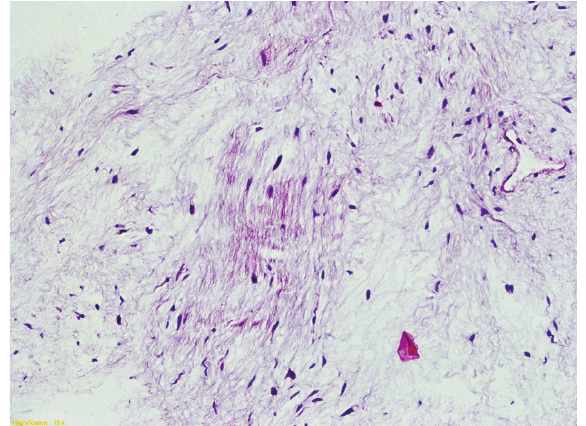
Figure 6: On histological examination, abundant myxoid matrix with few cells is observed. Notice the poor vascularization. Normal adjacent skeletal muscle is present on the left side of Figure 4.